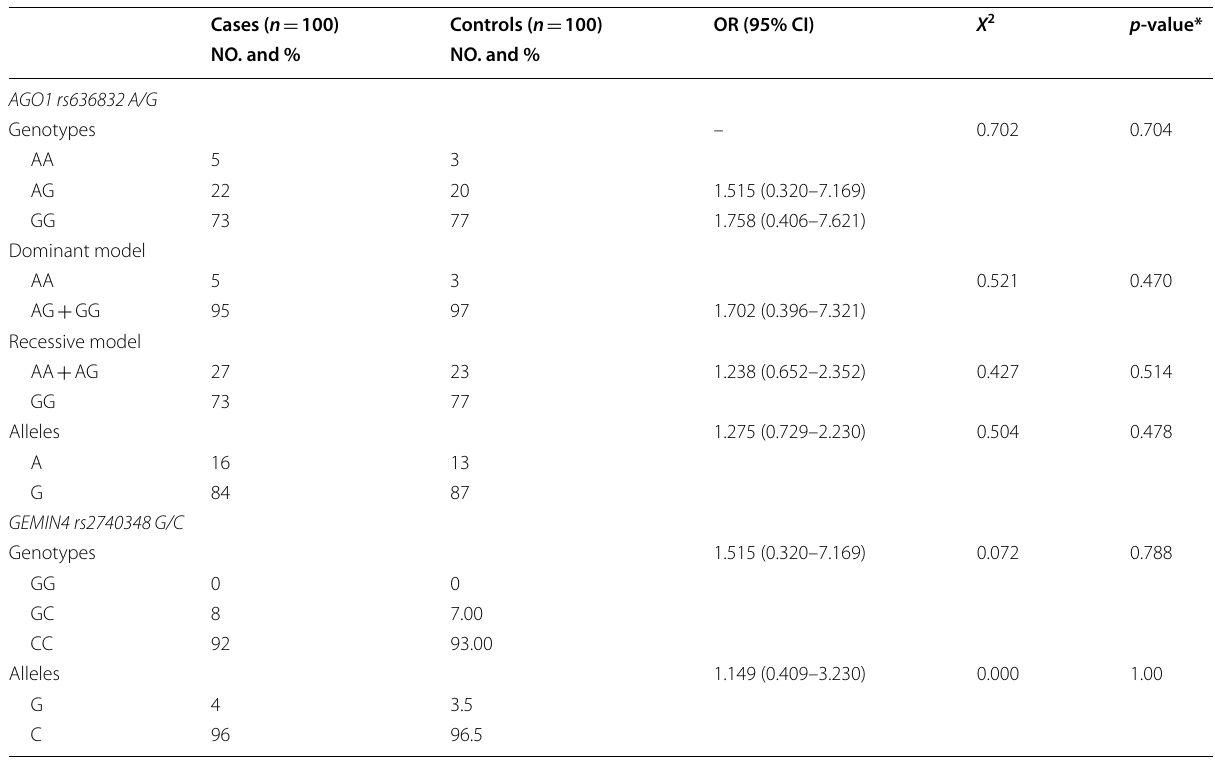
Table 1 Genotypes and allele frequencies among cases and